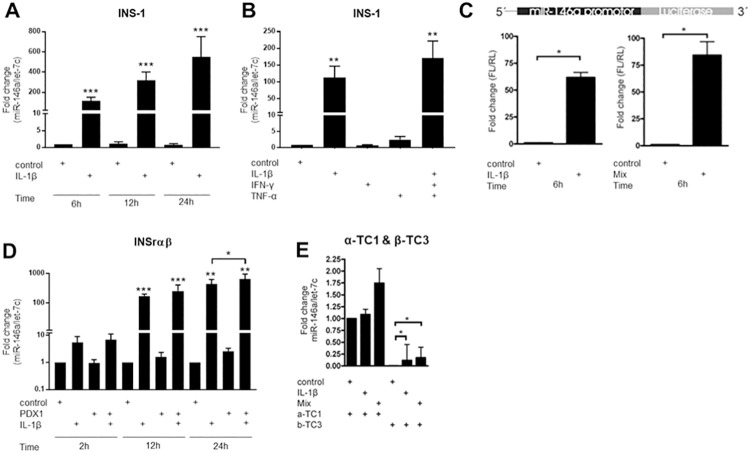
miR-146a-5p expression in α- and β-cell lines.(A) INS1 cells were exposed to IL-1β (160 pg/ml) for 6 h, 12 h and 24 h. The expression of miR-146a-5p normalized to the internal control let-7c was quantified with qRT-PCR. Mean ± SEM (n = 5). (B) INS1 cells were exposed to IL-1β (160 pg/ml), IFN-γ (5ng/ml) or TNF-α (10 ng/ml) or a mixture of all three cytokines for 8 h. The expression of miR-146a-5p normalized to the internal control let-7c was quantified with qRT-PCR. Mean ± SEM (n = 3). (C) The Luciferase promoter assay was conducted in INS1 cells exposed to IL-1β (160 pg/ml) for 6 h or IL-1β (160 pg/ml) and IFN-γ (5 ng/ml) for 6 h. The cells were pre-treated with transient transfection mix containing both miR-146a-5p promoter construct and a Renilla construct. Mean ± SEM (n = 4). (D) miR-146a-5p expression in the INSrαβ cell line with or without induced Pdx-1 by addition of doxycycline for 24 h prior to cytokine exposure to IL-1β (150 pg/ml) for 2 h, 12 h, or 24 h. The expression of miR-146a-5p and let-7c was quantified using qRT-PCR. Mean ± SEM (n = 4–5). (E) α-TC1 and β-TC3 cells were exposed for 24 h to IL-1β (160 pg/ml) or IL-1β (160 pg/ml) and IFN-γ (5 ng/ml). The expressions of both miR-146a-5p and the internal control let-7c were quantified by qRT-PCR. Mean ± SEM (n = 6–8). *p<0.05; ** p<0.01; *** p<0.001.